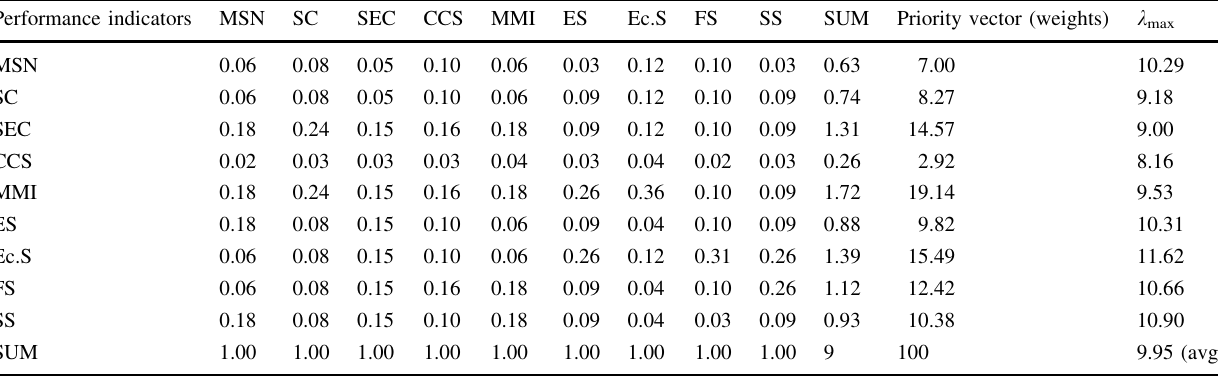
Table 4 Normalized relative weight matrix and priority vector Performance